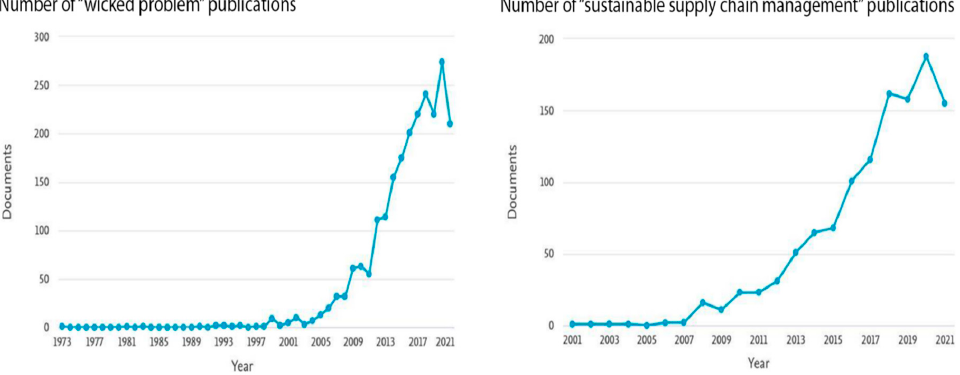
Figure 3. Amount of literature on wicked problems ( left ) and sustainable supply chain management ( right ) found via Scopus in September 2021.